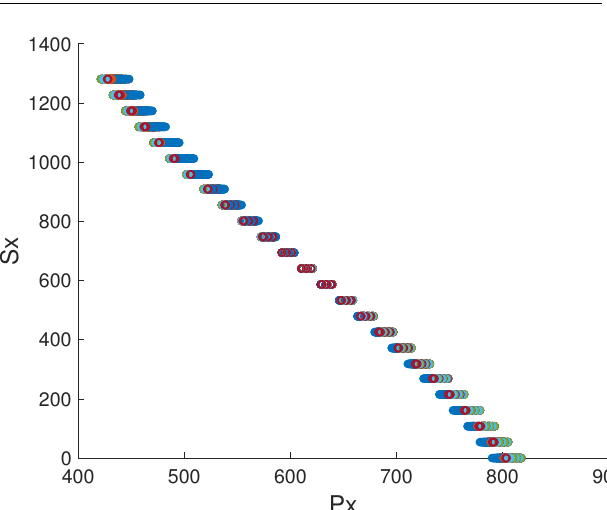
Figure 3 . Relationship between the input P x ( pupil x ) and output ( S x ). Di ff erent curves show the result for di ff erent parameters in the eye models.